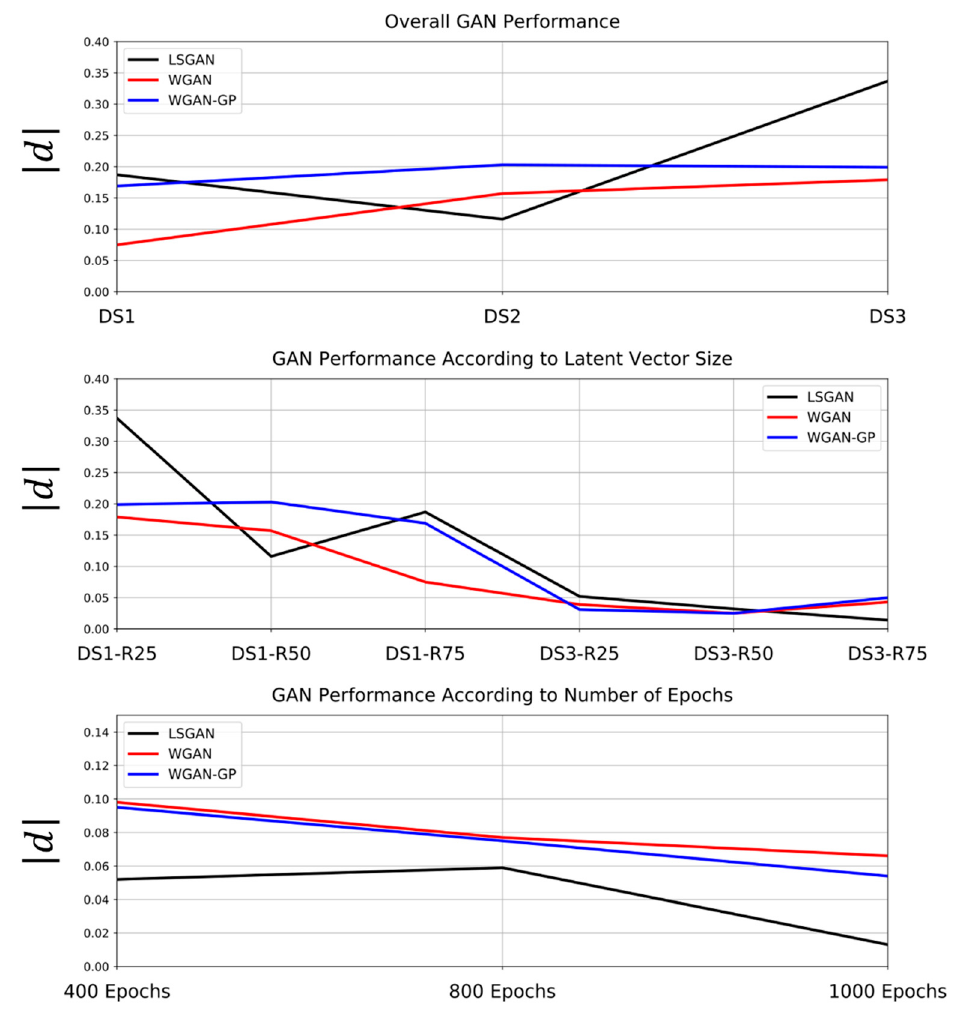
Figure 6. Parallel coordinate plots summarizing contents of Tables 3–6. Absolute difference values are obtained from robust equivalency testing.